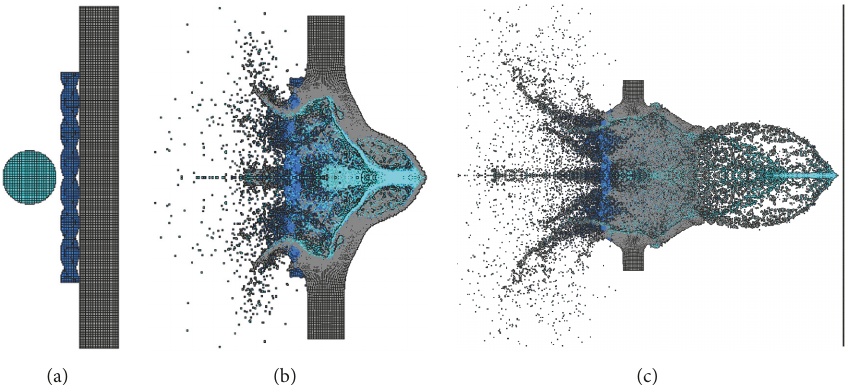
Figure 11: Impact of an aluminum projectile on a combined steel mesh-aluminum plate bumper (projectile aligned with aperture): (a) 𝑡 = 0 ; (b) 𝑡 = 0.55 𝜇 s; (c) 𝑡 = 1.65 𝜇 s.